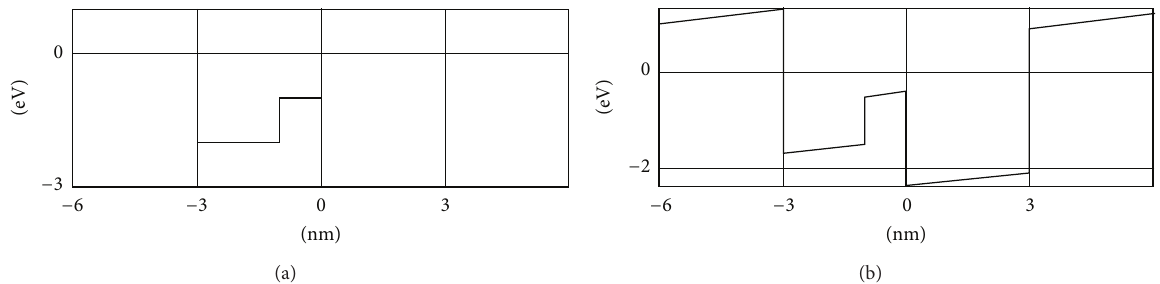
Figure 4: Complex-form potential without (a) and with the 𝐸 -field applied: 𝑞𝐹 = 0.1 (b).